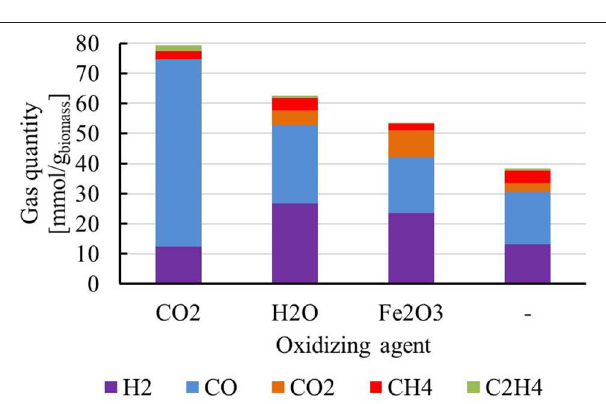
FIGURE 6 | Quantities of gases produced during gasification at 1,100 ◦ C with